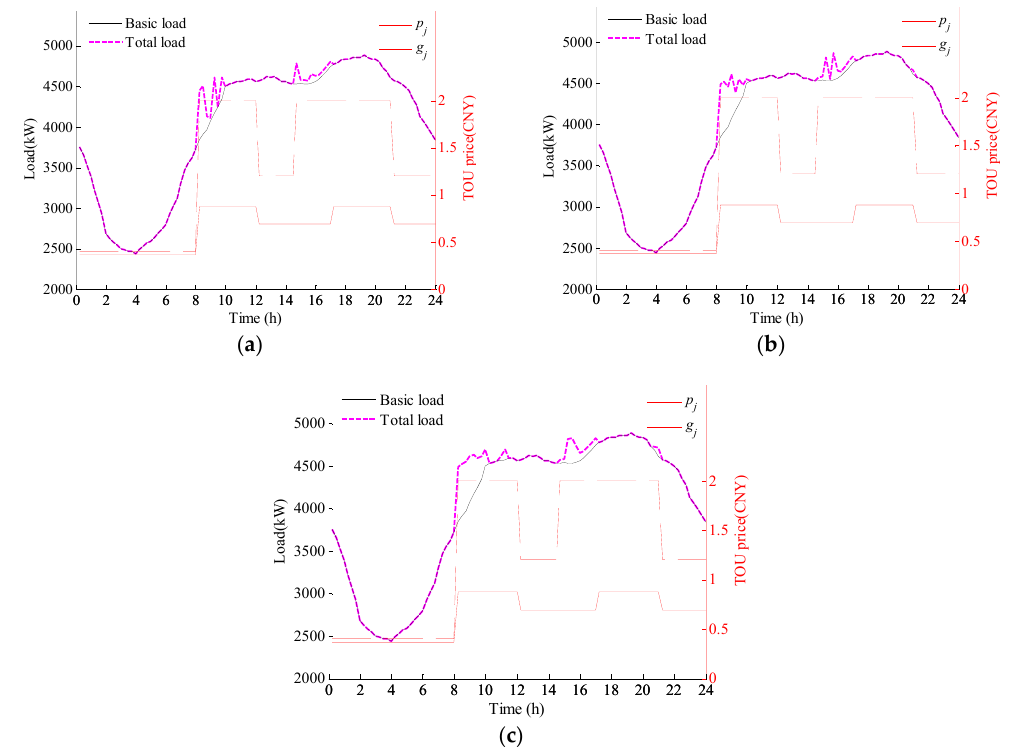
Figure 8. Charging load curve corresponding to Cc = ( a ) 24; ( b ) 32; ( c ) 40.